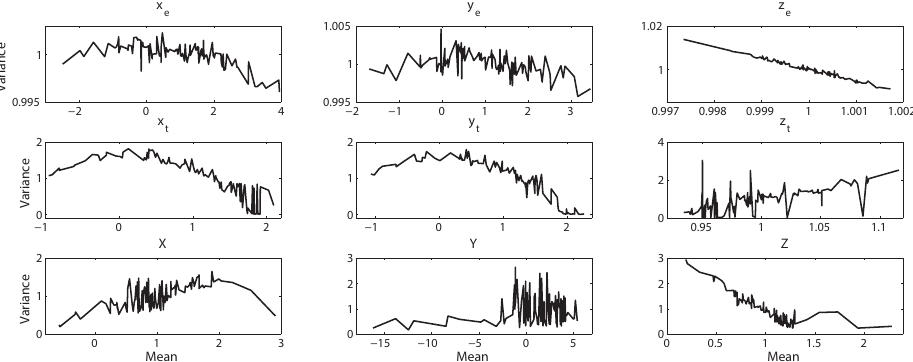
Fig. 2. Variance of model as a function of its mean for the sample of 109 model configurations considered and for the 9 model variables.